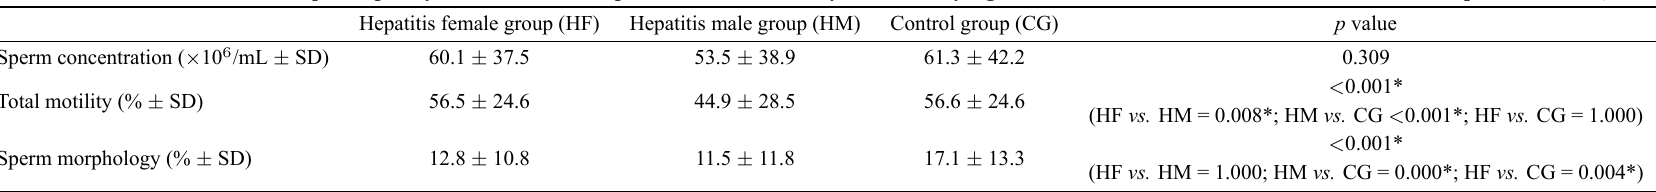
Table 1. The results of basic sperm quality assessment of samples included into study. Statistically significant differences are marked with an asterisk ( p value < 0.05).